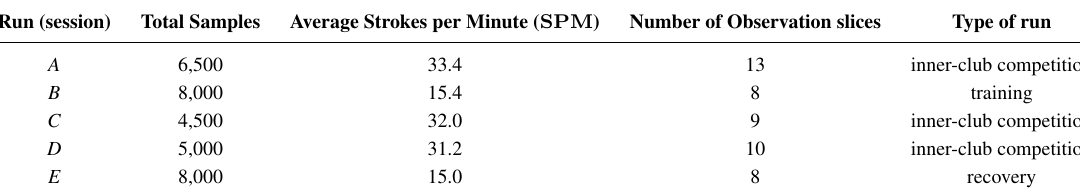
Table 2. Runs and their main features.